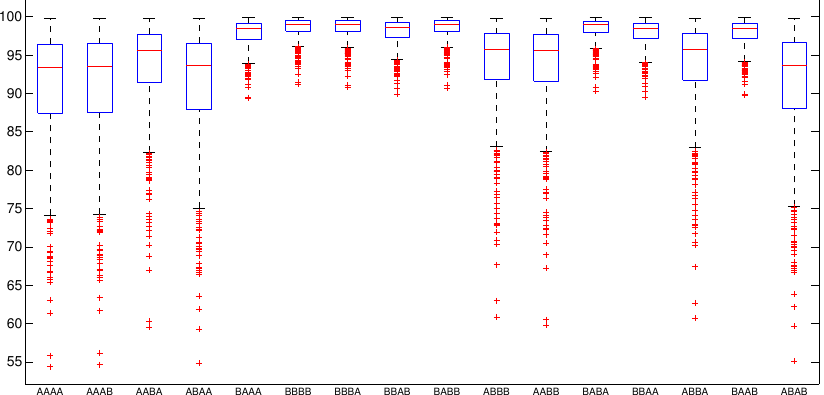
Figure 6. Box and whiskers plot showing the results of various intervention strategies on the reproduction number for humans with the sensitive strain R s